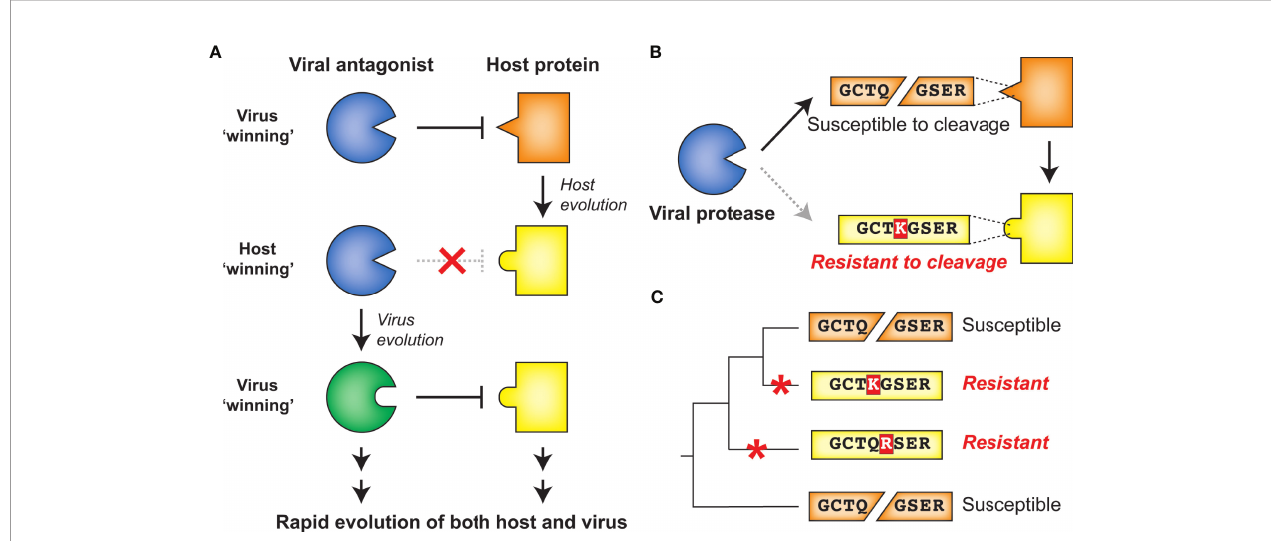
FIGURE 2 | Host-virus evolutionary arms races can be driven by protease-target interactions. (A) Host-virus arms races occur when there is direct interaction between host and viral factors, which places evolutionary pressure to select for variants. In this scenario, a viral antagonist recognizes and inactivates a host protein, driving host evolution away from this interaction. The necessity of host target cleavage for virus replication in turn drives evolution of the viral antagonist to reestablish host target recognition. (B) Single amino acid changes in the sequence-speci fi c cleavage motif can eliminate cleavage by a viral protease. (C) Across a phylogenetic tree, changes can occur recurrently resulting in differential susceptibility between even closely related species. Red asterisks mark the branch in which an amino acid change occurred that alters cleavage